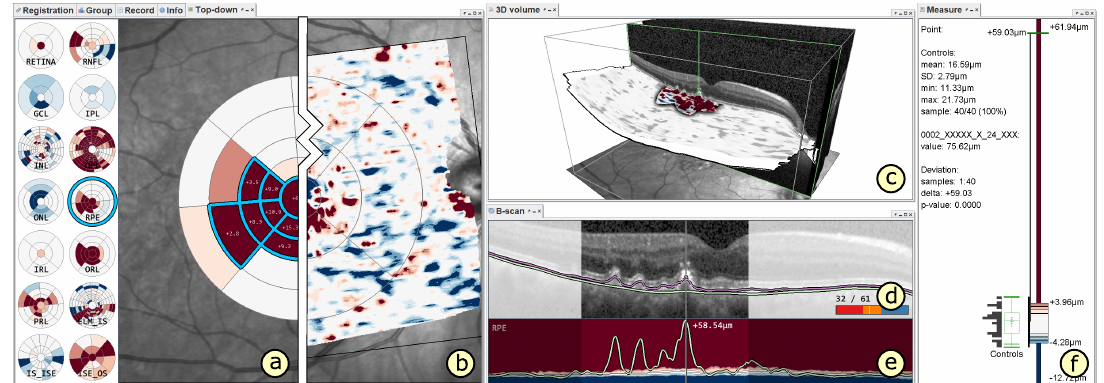
Figure 8. A visual analysis tool for retinal layer thickness. A top-down view shows either grids ( a ) or maps ( b ). A 3D view presents a volume visualization of raw OCT data ( c ), and a 2D cross-sectional view displays individual B-scans ( d ) and thickness profiles of selected layers ( e ). All views are linked, selections in grids or maps are highlighted, and details are shown in a measurement view ( f